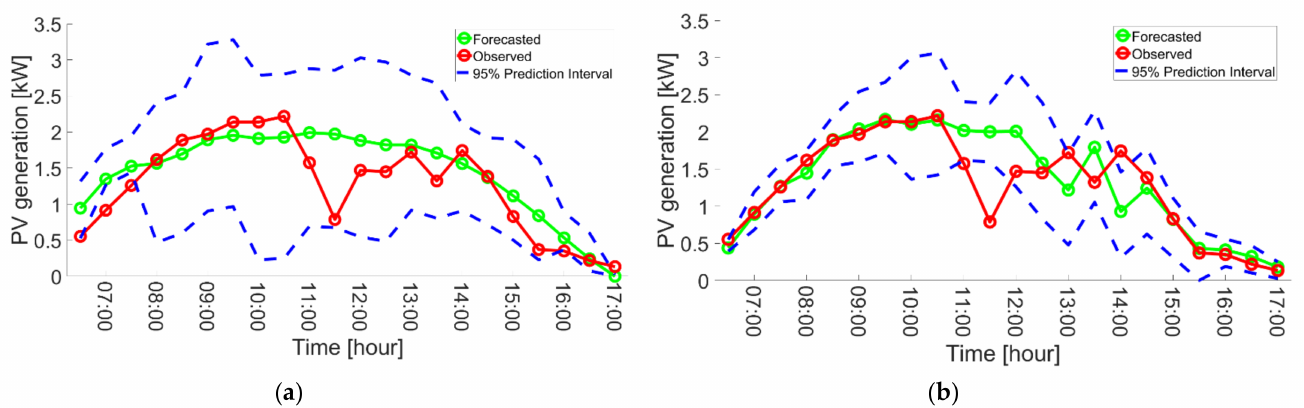
Figure 10. Deteriorating of forecasted PV generation for PV (iii) on 25 July 2014; the worst RMSE by the multiple PV forecast model among 30 days performances. ( a ) Single PV forecast model for PV (iii) (RMSE = 0.372 kw). ( b ) Multiple PV forecast model for PV (iii) (RMSE = 0.382